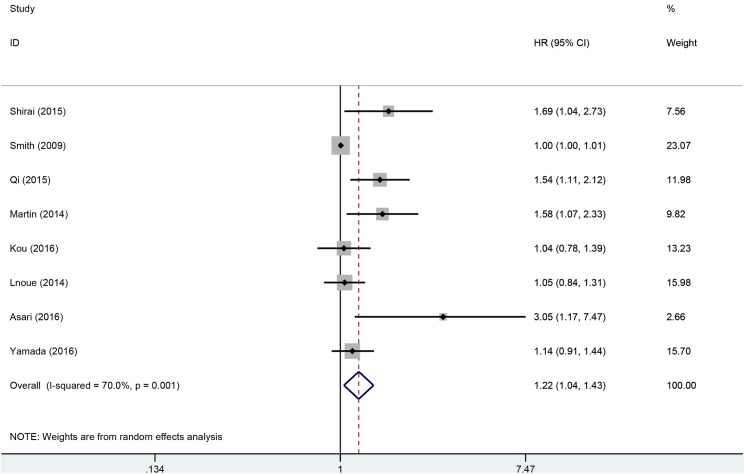
Forest plots for the association between PLR and OS.